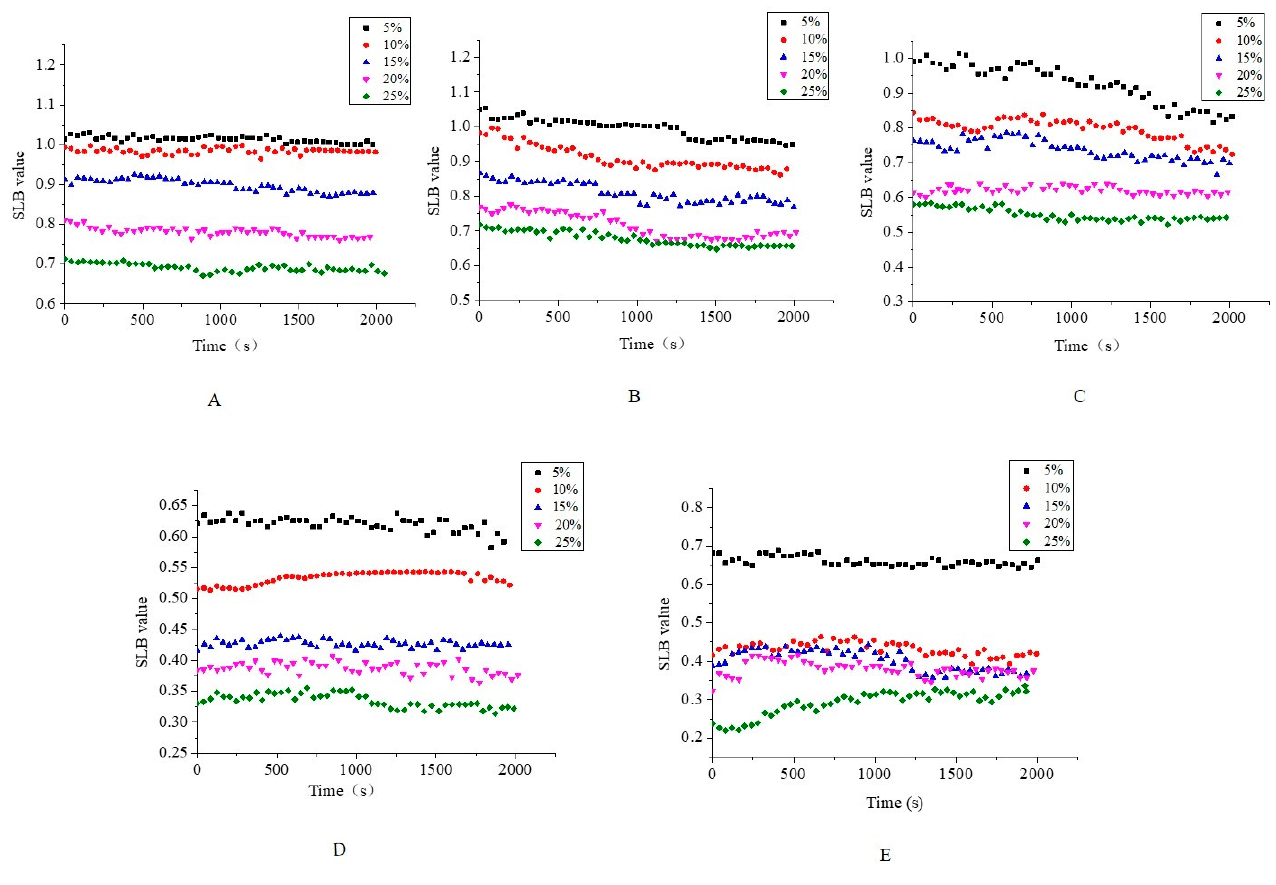
Figure 4. The microrheological properties of S/O/W emulsions at different concentrations of NaCas and different propor- tions of S/O phase determined by an optical microrheometer ( a ) MSD ( b ) SLB (A, 2 wt% NaCas; B, 4 wt% NaCas; C, 6 wt% NaCas; D, 8 wt% NaCas; E, 10 wt% NaCas).